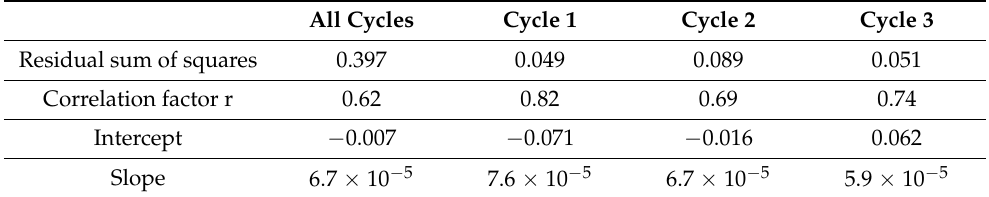
Figure 4. Dependences of the PC7 value on the applied voltage (black line) and the corresponding linear regressions (red line): ( a ) for all cycles of voltage change; ( b ) for the first cycle; ( c ) for the second cycle; ( d ) for the third cycle. Table 1. Linear regression and correlation parameters of dependences from Figure 4. All Cycles